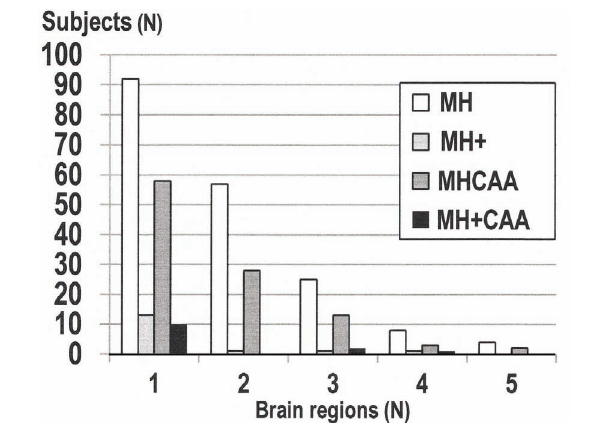
FIGURE 2 |The distribution of the cerebral microhemorrhages (MH) and the lesions with > 5 siderophages (MH + ). artery was often found in the center/near the center of the lesion, but when in association with larger infarcts it was not possible to show which vessel had